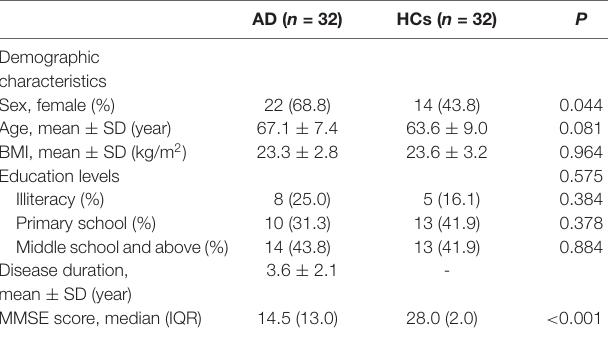
TABLE 1 | Demographic and clinical characteristics of the samples under